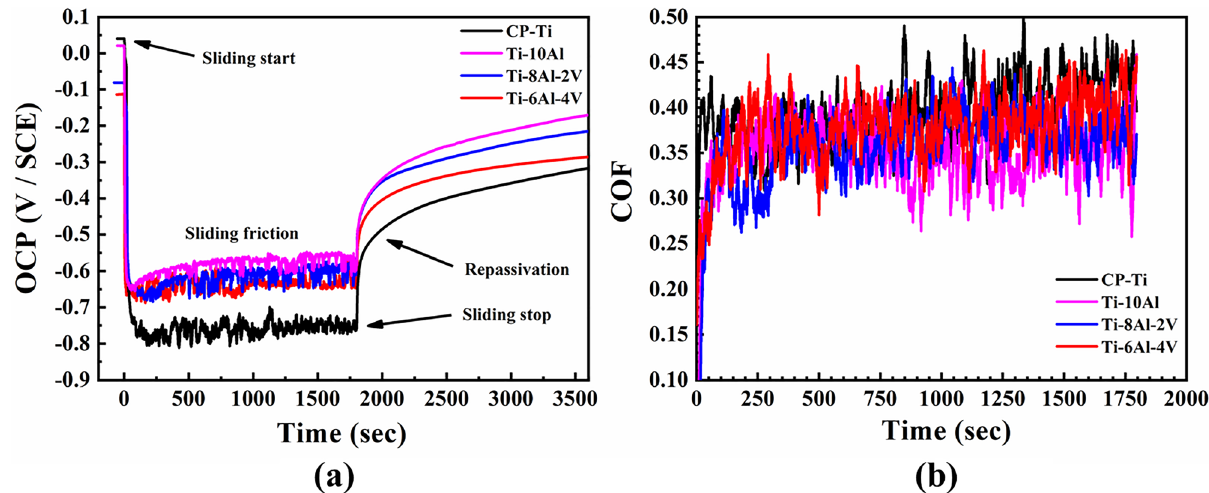
Figure 8. Tribocorrosion analysis: ( a ) OCP and ( b ) COF results.